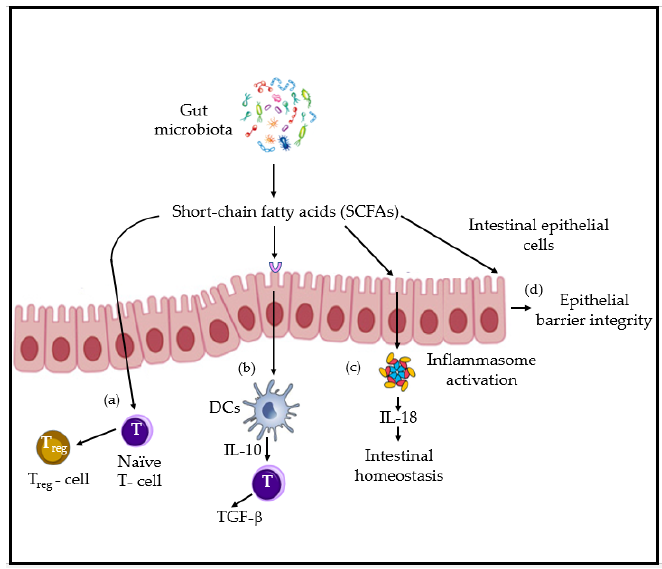
Figure 2. Short-chain fatty acids (SCFAs) acetate, butyrate and propionate produced by gut microbiota promote: ( a ) the differentiation of naïve T cells into Treg cells; ( b ) the activation of DCs to induce TGF- β release by activated T cells; ( c ) intestinal homeostasis, through inflammasome activation (release of IL-18); ( d ) the production of intestinal antimicrobial peptides (AMPs) and epithelial barrier integrity [13,25].